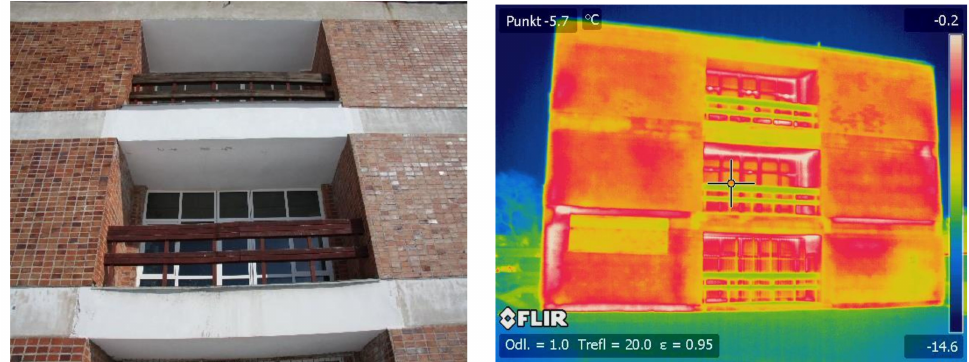
Figure 4. View of the gable wall, to be insulated and a thermal image [photo authors]. An increased temperature is observable (Figure 3), which highlights significant heat loss caused by structural elements (horizontal reinforced concrete beams), even